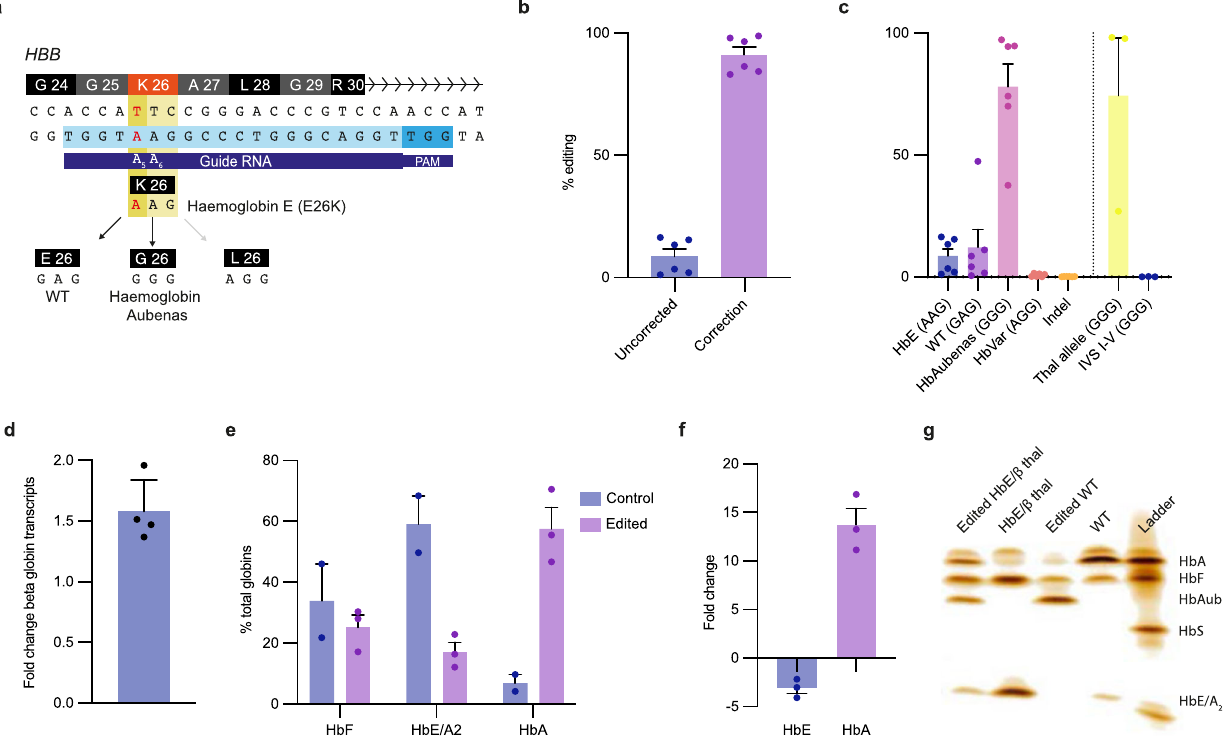
Fig.1|BaseeditingoftheHaemoglobinE.a ABEeditingstrategytorepairtheHbE mutation.ThetargetadenineinHbE(A 5 )liesatposition5oftheprotospacer,witha bystander adenine (A 6 )atposition 6. The HbE codon(AAG)can be edited with one of three outcomes depending on which adenine has been deaminated: editing A 5 alonerevertsthecodontoWT(GAG),bothA 5 andA 6 convertsittoanormalvariant that codes for β Aubenas (GGG) and A 6 alone converts it to a previously undescribed codon (AGG). b Adenine base editing using ABE8e V106W highly ef fi ciently con- verts the HbE codon to normal or a normal variant ( n =6 biologically independent samples). c Codon editing outcomes on the HbE allele and the non-target